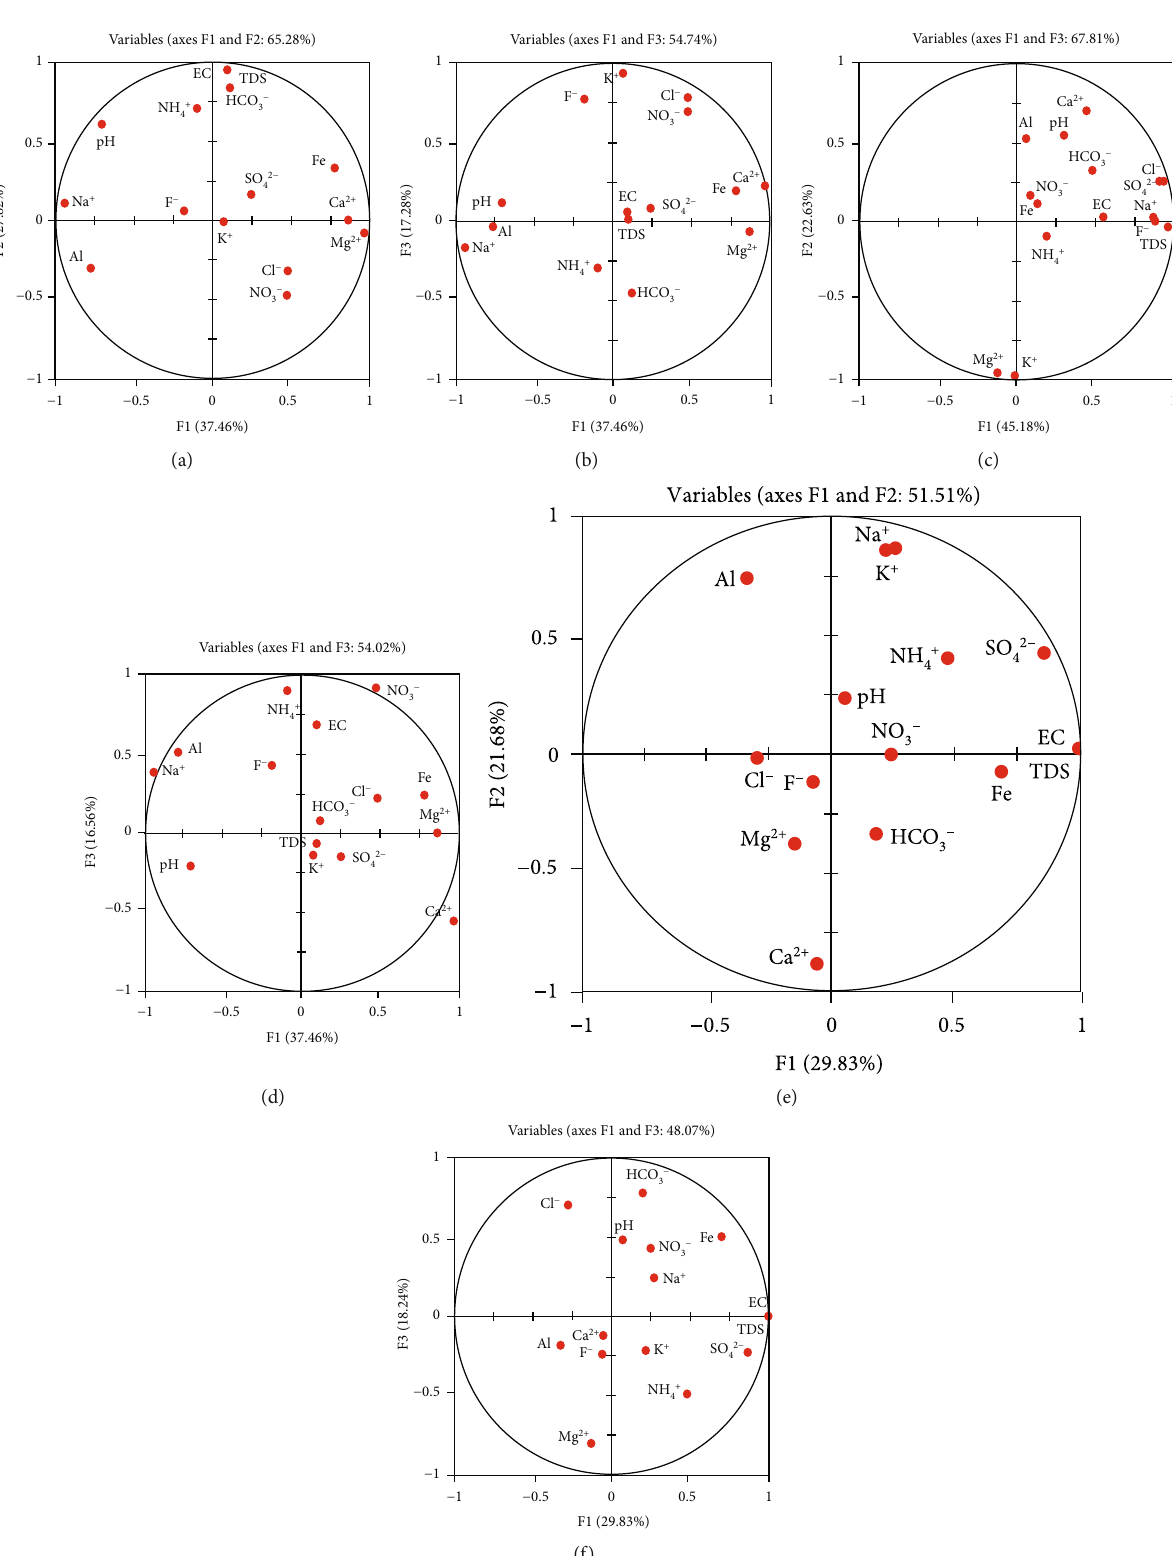
Figure 10: Principal component analysis